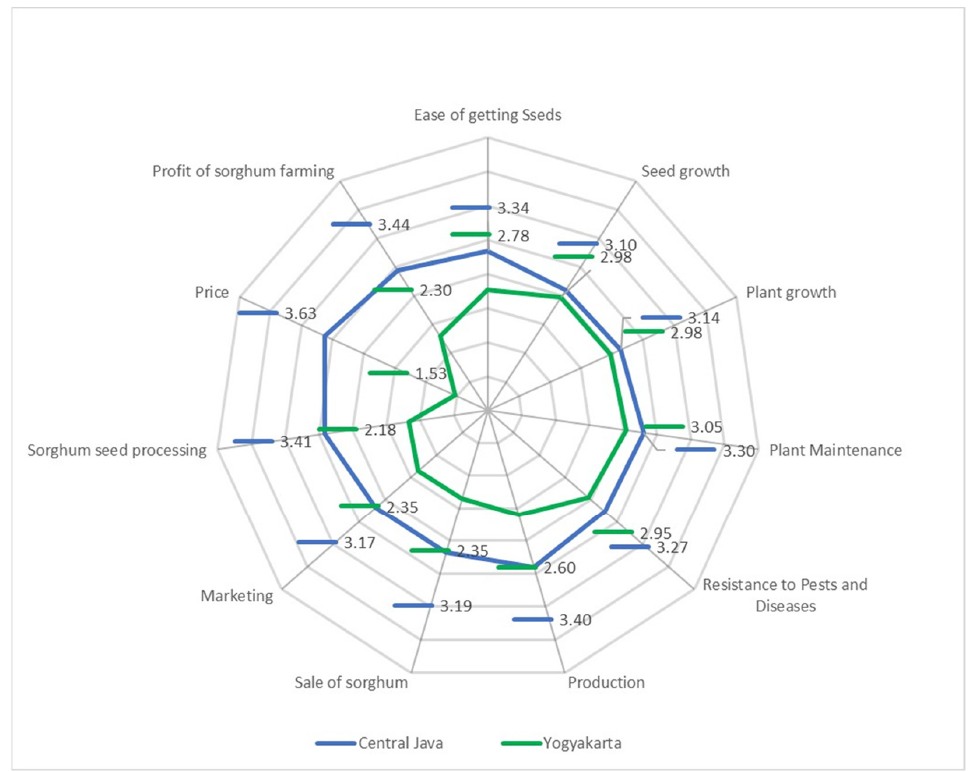
Figure 3. Farmers’ perceptions of sorghum development in Central Java and Yogyakarta, 2022. Source = Primary Data 2022 (processed).